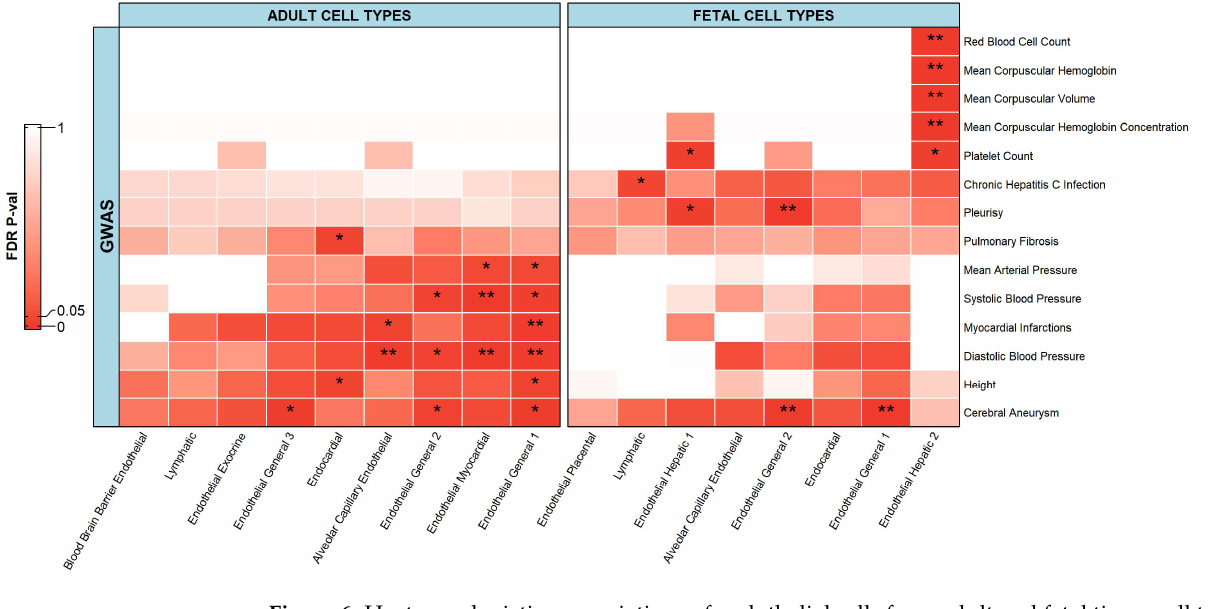
Figure 6. Heatmap depicting associations of endothelial cells from adult and fetal tissue cell types with respective phenotypes. The heatmap follows a gradient from red to white as the values go from 0.00 to 1.00. ** represents a significant association with an FDR adjusted p -value less than or equal to 0.01. * represents a significant association with an FDR adjusted p -value less than or equal to 0.05 but greater than 0.01.